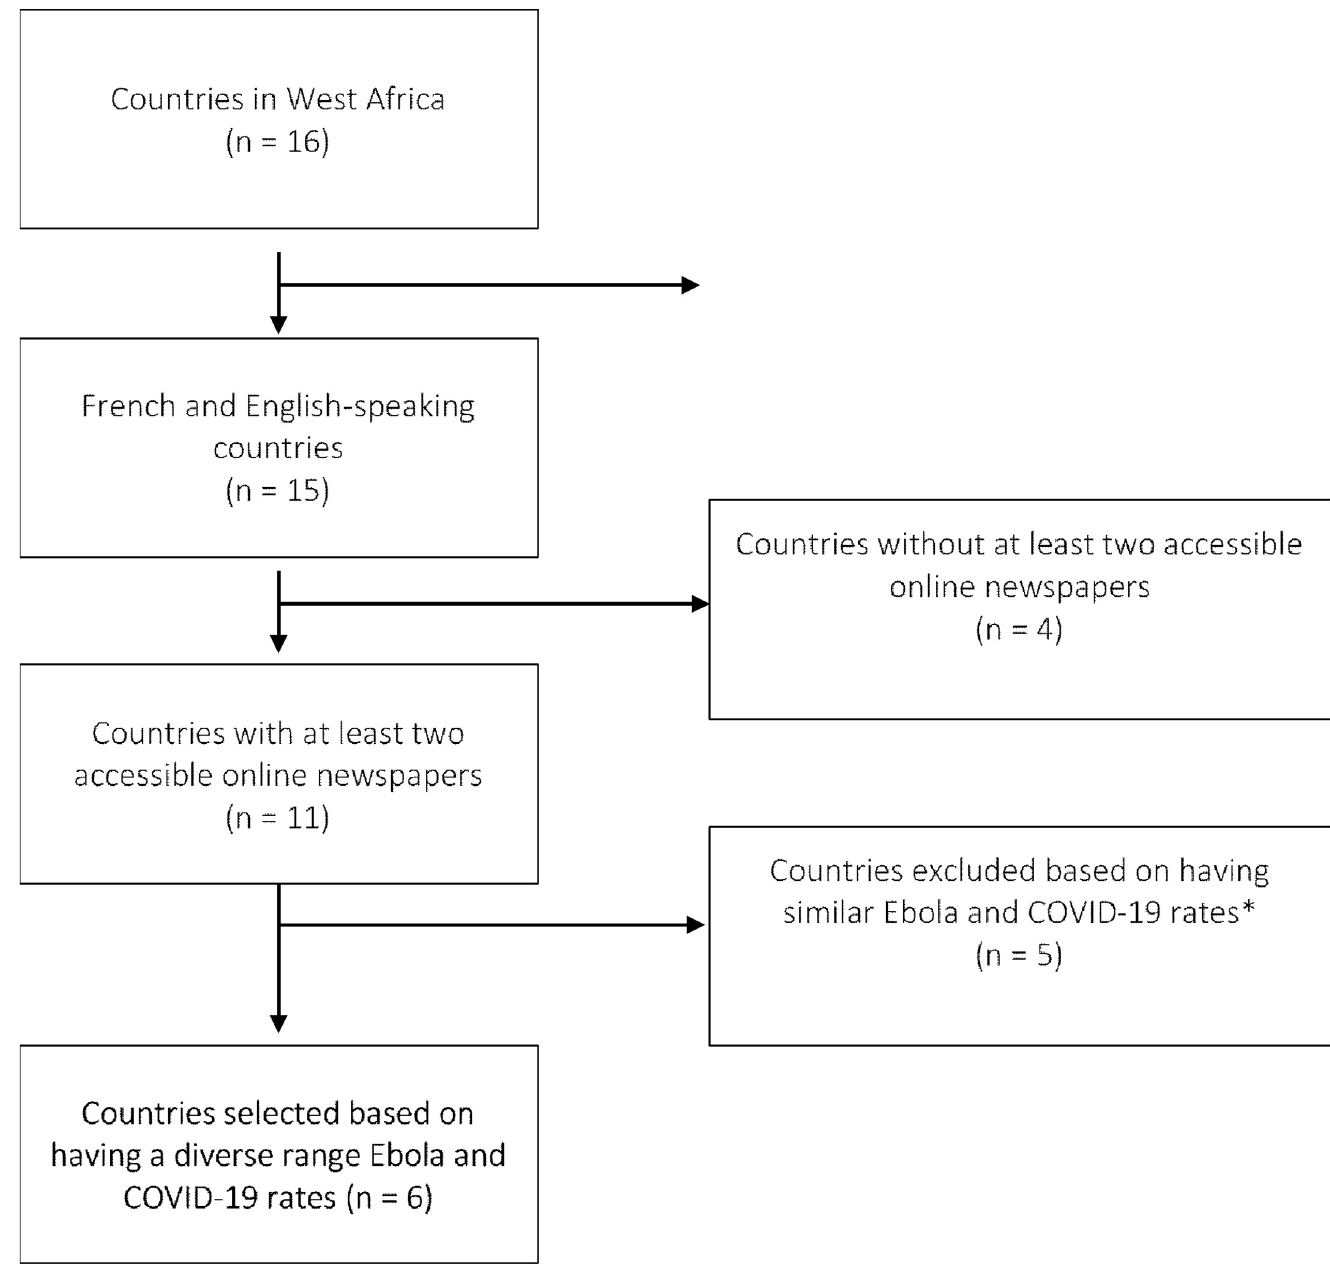
Fig 1. Country inclusion flow